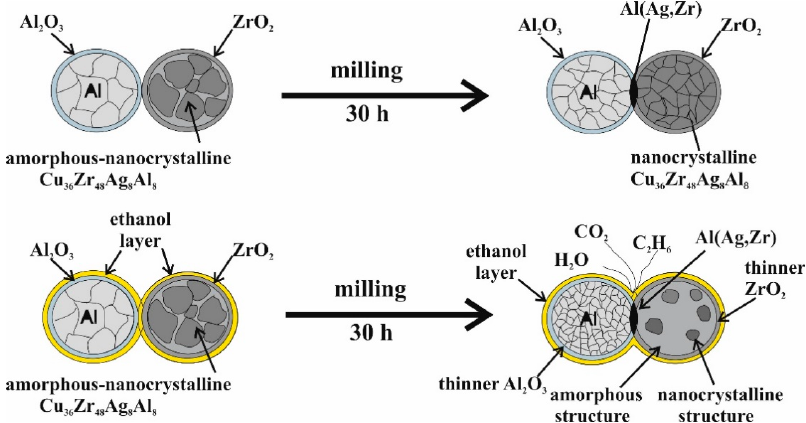
Figure 13. Schematic of the milling process without and with ethanol.